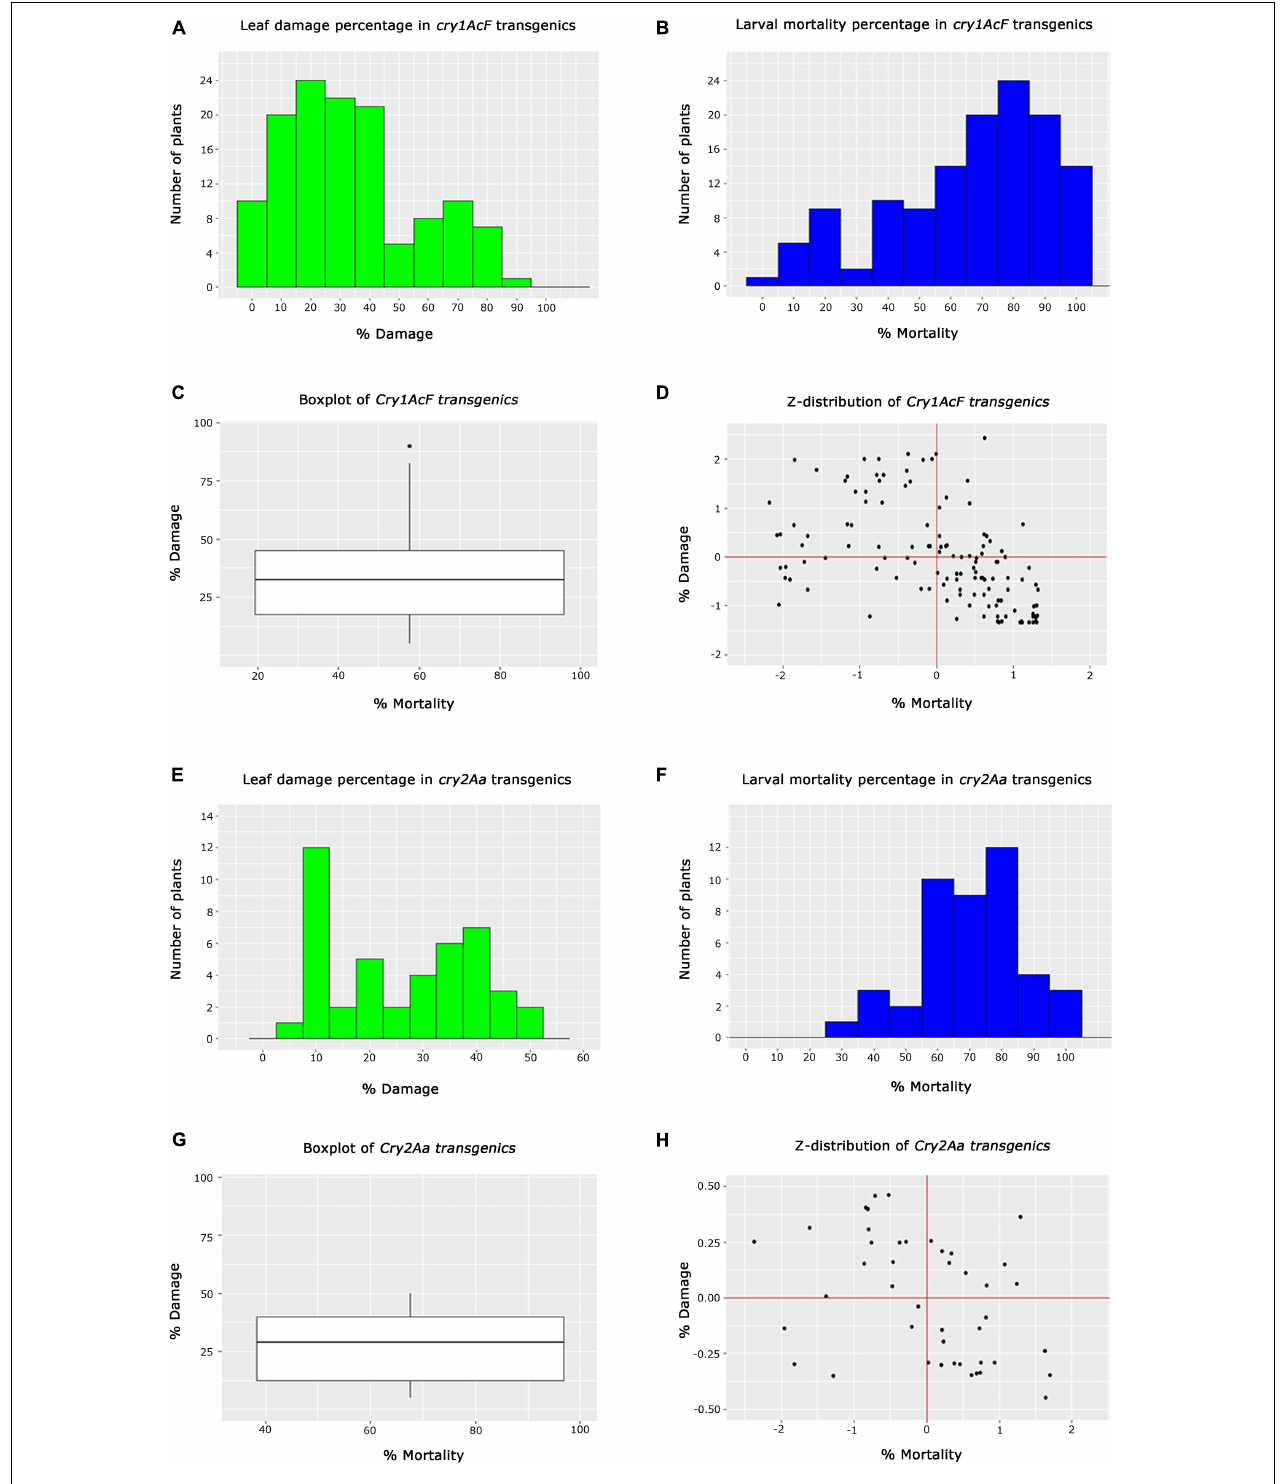
FIGURE 5 | Analysis of T 2 generation transgenic cotton plants toward Helicoverpa armigera challenge. (A,B) Histograms representing the performance overview of cry1AcF transgenic plants based on % leaf damage and % larval mortality, respectively, (C) box whisker plot depicting the performance spread of cry1AcF transgenic plants, (D) Z-distribution analysis of cry1AcF transgenic plants; (E,F) Histograms representing the overview of cry2Aa transgenic plants based on % leaf damage and % larval mortality, respectively, (G) box whisker plot depicting the performance spread of cry2Aa transgenic plants, and (H) Z-distribution analysis of cry2Aa transgenic